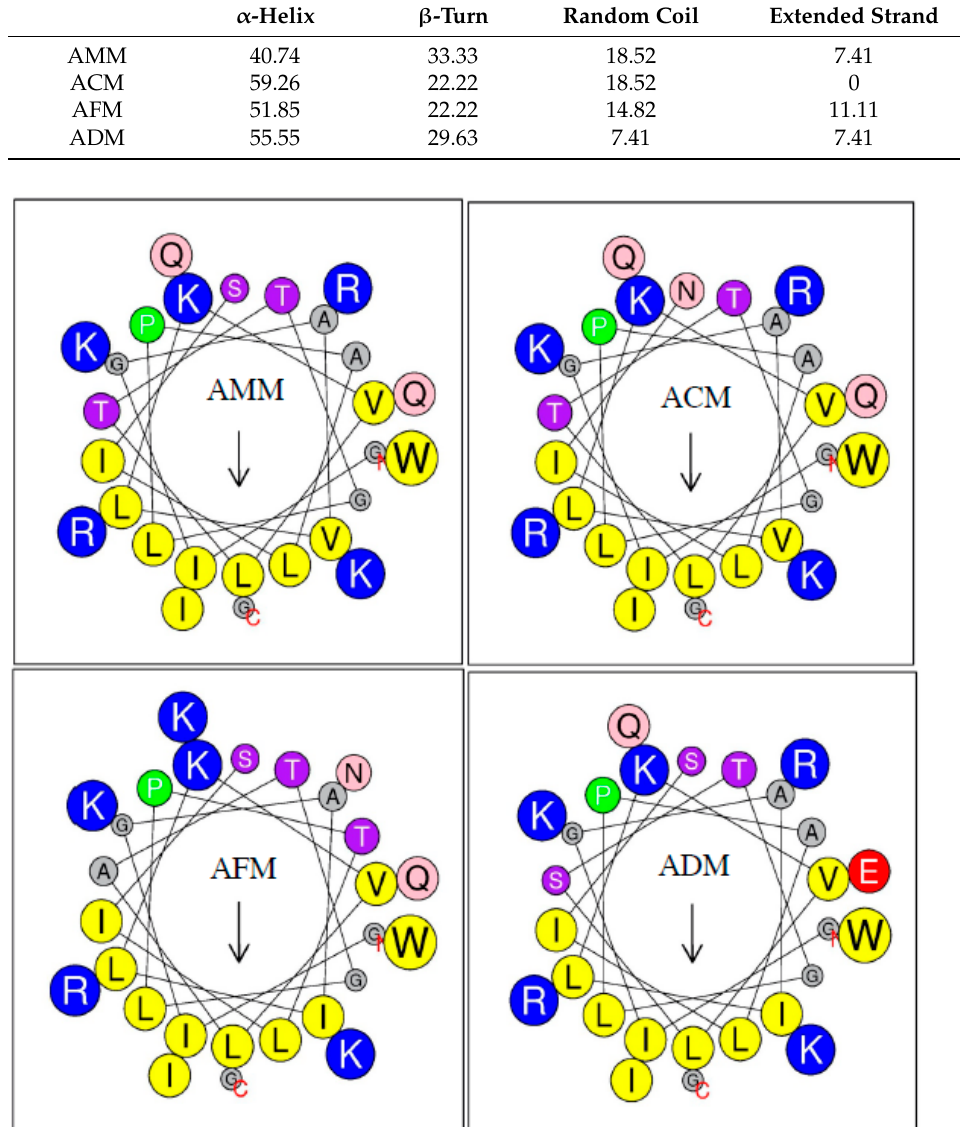
Table 3. Representation of the melittin secondary structure from honey bees predicted via SOPMA (in percentages).